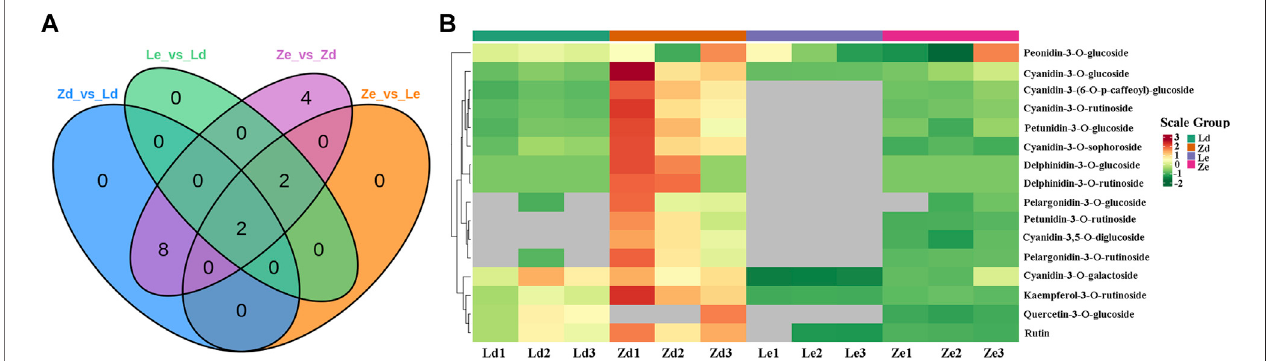
FIGURE 6 | Analysis of differentially accumulated metabolites (DAMs) in eggplant peel samples from the fruit apex (Ld and Zd) and under the calyx (Le and Ze) of L andZlineeggplants,respectively. (A) VenndiagramshowingoverlappingDAMsinvariouscomparisonsofsamplesfromLandZlines. (B) HeatmapofDAMsinvolvedin biosynthesis of anthocyanins.